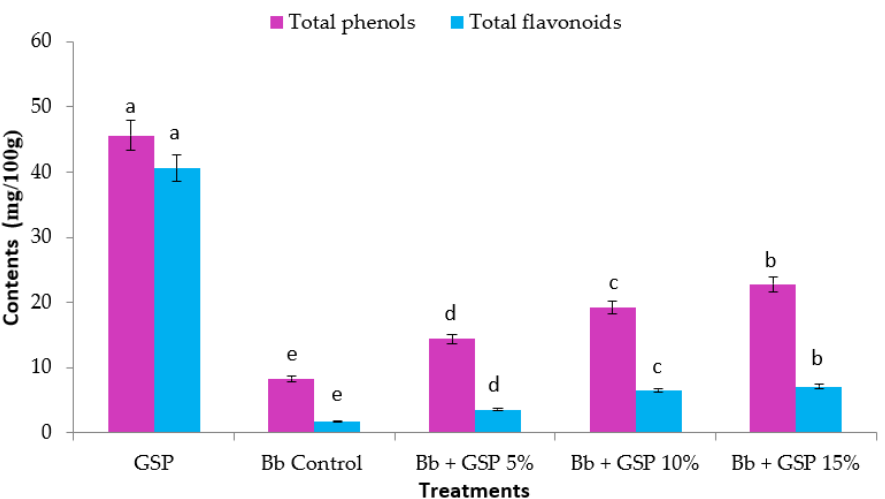
and the results are shown in Figure 4. The results demonstrated that GSP has a higher antioxidant capacity; the effect was related to the GSP levels. Grape seed extract had a higher antioxidant capacity than control bread (no additives). These findings agreed with those of Guaita and Bosso [71], who discovered that grape seeds contain a higher antiox ‐ idant capacity than grape peels, suggesting a relationship between tannin content and antioxidant capacity. The acetonic extract of grape seed had substantially higher total phe ‐ nolic and flavonoid content, as well as the best DPPH scavenging capability of the extracts tested [72]. Moreover, the antioxidant activity in control bread was 29%. This activity was most likely caused by the Maillard reaction, as Maillard reaction products, particularly melanoidins, have antioxidant properties. The addition of 7.5% grape seed boosted the antioxidant capacity with radical inhibition reaching 69%. According to the findings, add ‐ ing grape seed to bread boosted its antioxidant capacity. The incorporation of phenolic compounds may be responsible for the increased antioxidant activity of bread supple ‐ mented with grape seed [68]. The same trend was noticed with the ABTS test (Figure 5). These findings show that GSP fortified bread contains substantial quantities of phenolic compounds, which are nutritional effective. Phenolic antioxidants are a type of food ‐ ac ‐ tive component that can be used to add extra health advantages to a variety of value ‐ added processed foods. At 2.5, 5, and 7.5 g GSF/100 g WF, the bread antioxidant activity increased significantly [37].